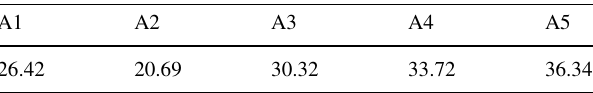
Table 6 The stabilized NO conversions of the activated coke samples